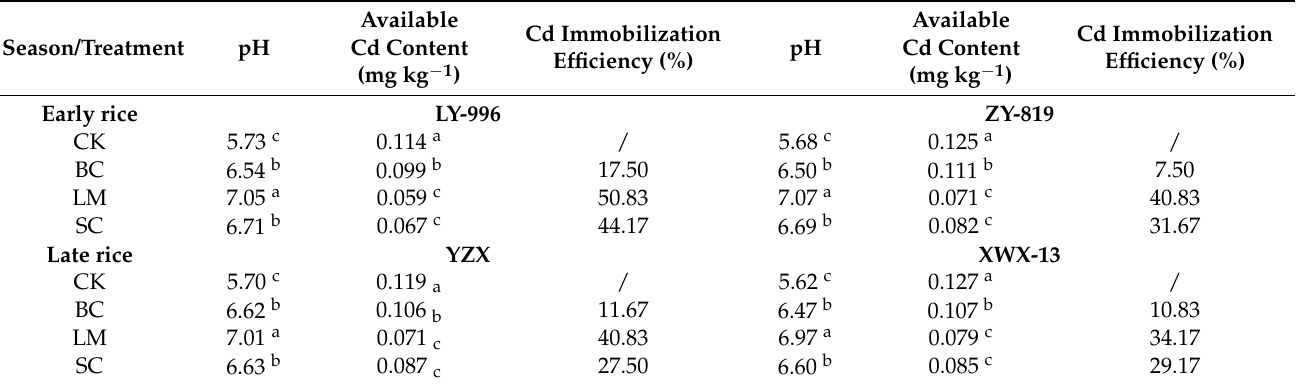
Table 2. Effects of soil amendments on the soil pH and Cd bioavailability in the double-cropping rice